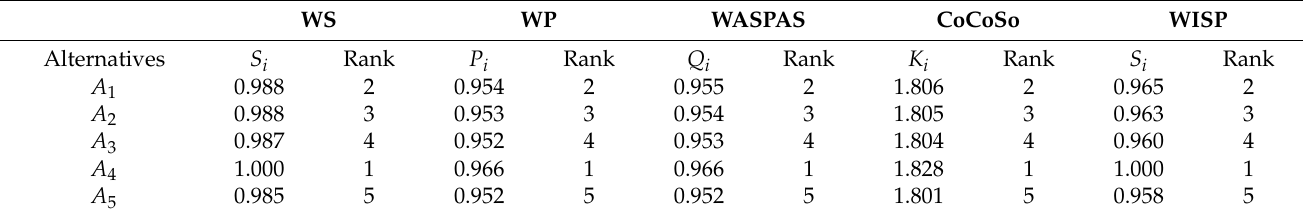
Table 19. Ranking of alternatives on the basis of 150 virtual respondents and grey methods.